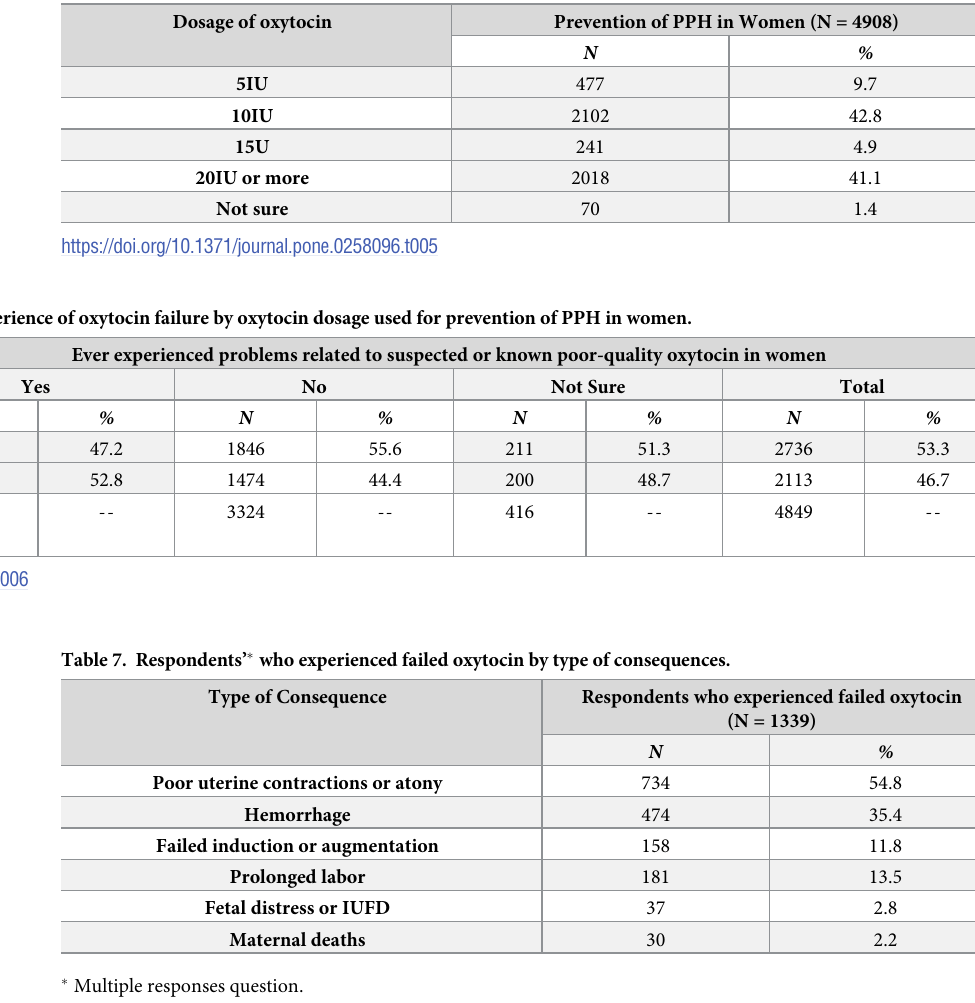
� Multiple responses